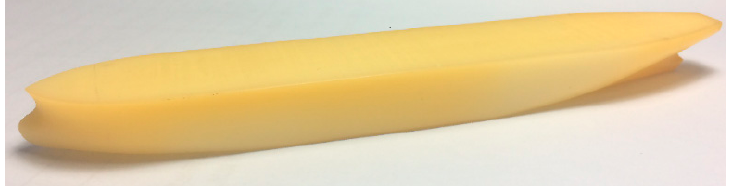
Figure 2. Printed model of KVLCC2 (FDM, scale 1:2000).